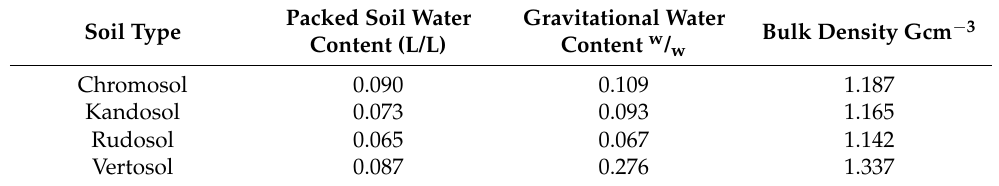
Table 3. Initial soil moisture content of specific soil types at the time of column assembly, included in lysimetry experimentation performed in Wagga Wagga, NSW, measured as gravimetric water